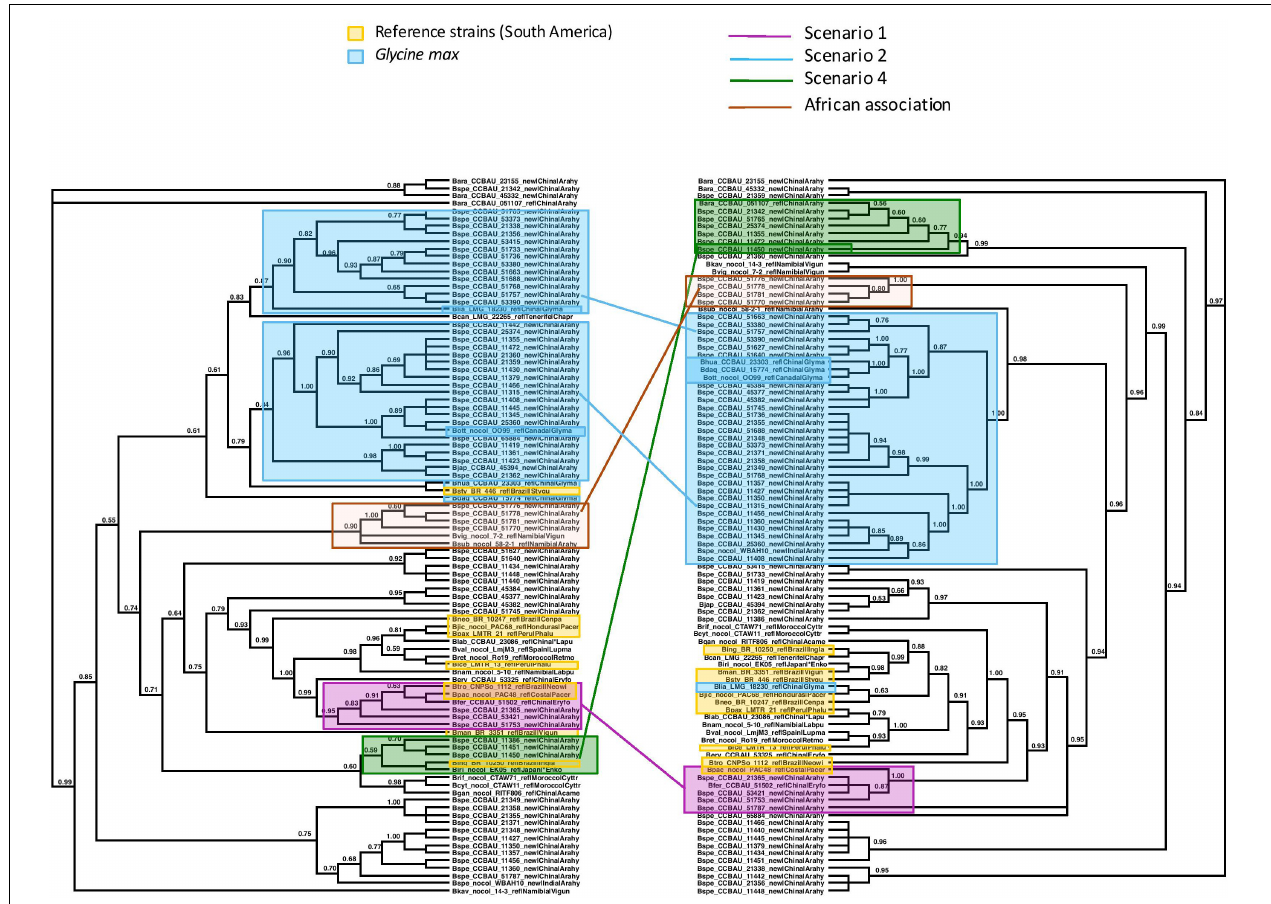
FIGURE 4 | Maximum Likelihood trees of the concatenated sequences of 16S region and the housekeeping genes r ecA, dnaK, glnII on the left, labeled “Species Tree”, and on the right, of the symbiotic nodC gene. Nodes with lower bootstrap support than 60% were collapsed into polytomies. Bootstrap support is coded for each node. The two trees differ significantly in topology (AU test p < 0.05). We identified clades or clusters of strains of bacteria on the two trees that illustrated the different scenarios outlined in Figures 1 , 2 . Clades or clusters are identified with a color-coding by their host plant, and different colored lines to illustrate the different scenarios join individual strains or clades on the two trees. When more than one member of a clade or cluster followed the same evolutionary scenario we chose a single one to illustrate it. The scenarios shown do not represent all events that can be traced from this phylogeny, but are representative of the events that it elucidates. We also mark a clade of bacteria isolated from peanut in China that cluster with Namibian bacterial isolates on the species tree but form an isolated clade that includes no reference strains on the nodC